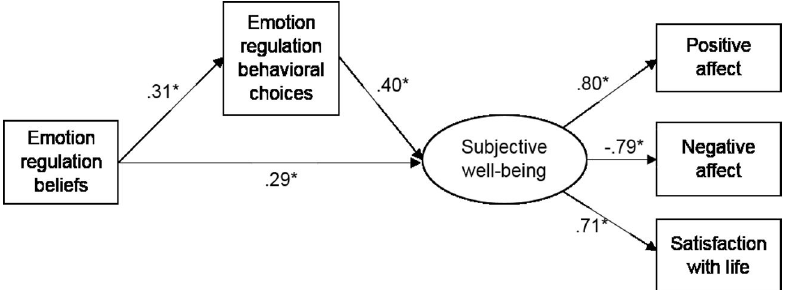
Figure 2. Model Showing Standardized Regression Coefficients for the Relation Between Emotion Regulation Beliefs, Emotion Regulation Behavioral Choices, and Subjective Well-Being. Emotion Regulation Choices Partially Mediated the Relation Between Emotion Regulation Beliefs and Subjective Well-Being. * p <